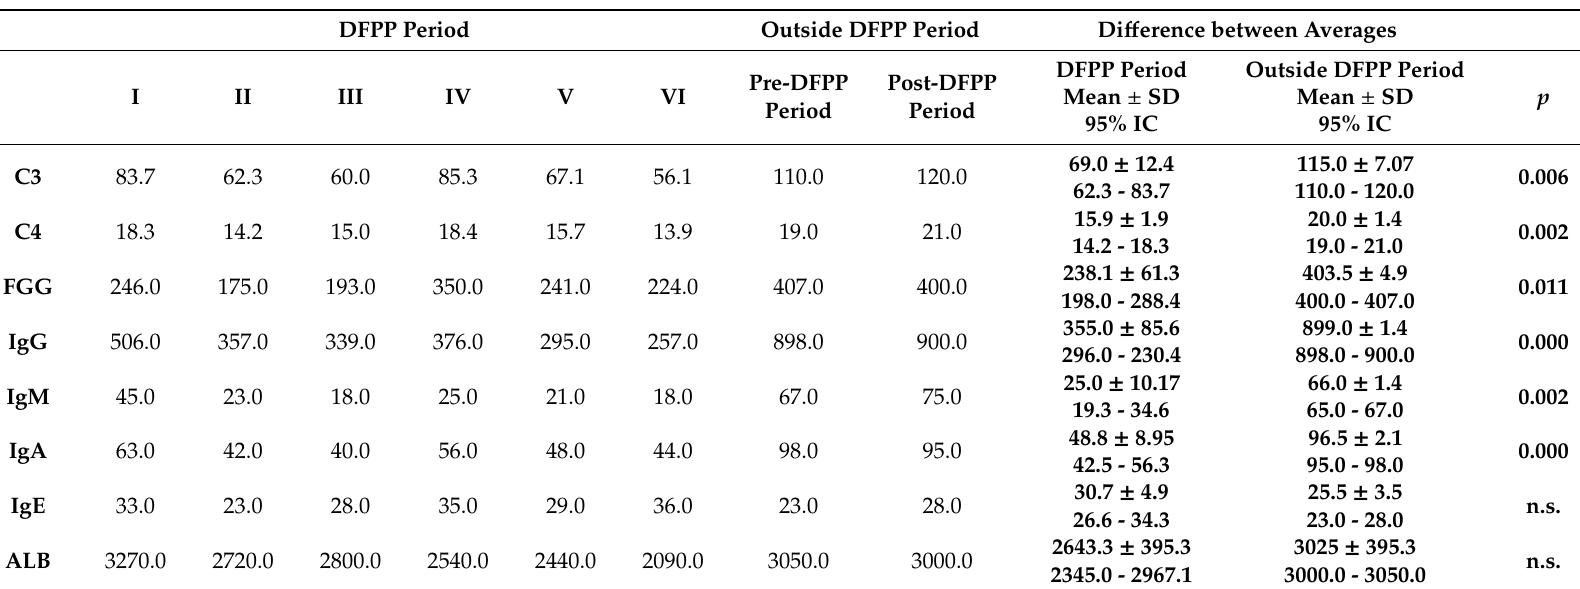
Table 1. All values of albumin (ALB), immunoglobulin G (IgG), A (IgA), M (IgM), E (IgE), gamma-fibrinogen (FGG), and the C3 / C4 components of the complement measured immediately after each DFPP session performed every other day, except for session IV, in which the blood sample was executed just before treatment. Measurements of ALB, IgG, IgA, IgM, FGG, and C3 / C4 are shown in mg / dL, and IgE is shown in IU / mL. Di ff erences between means of species’ values measured during and outside DFPP period, with related p values, are shown in